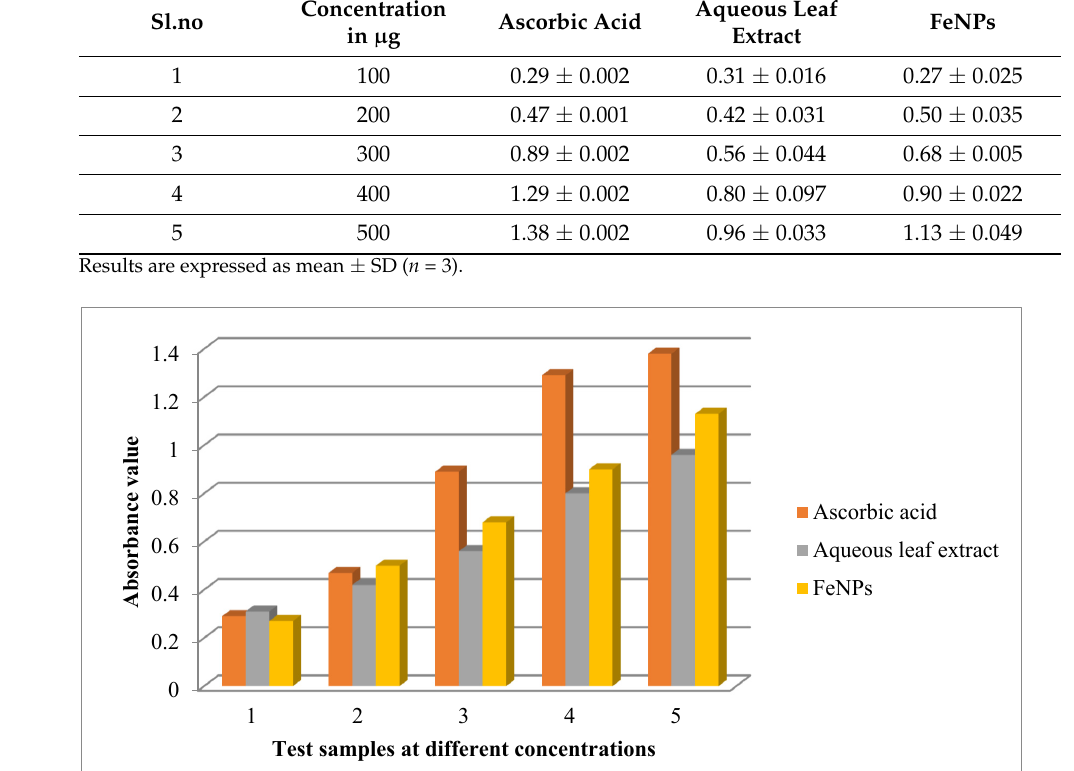
Table 5. PM assay of aqueous leaf extract of V. leucoxylon and its synthesized iron nanoparticles.